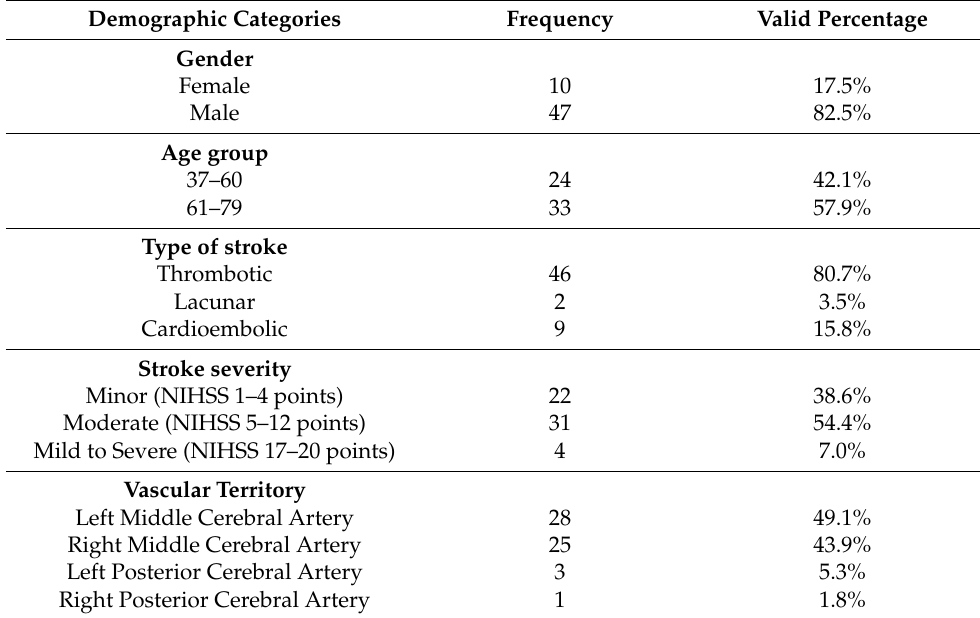
Table 1. Patients’ characteristics and